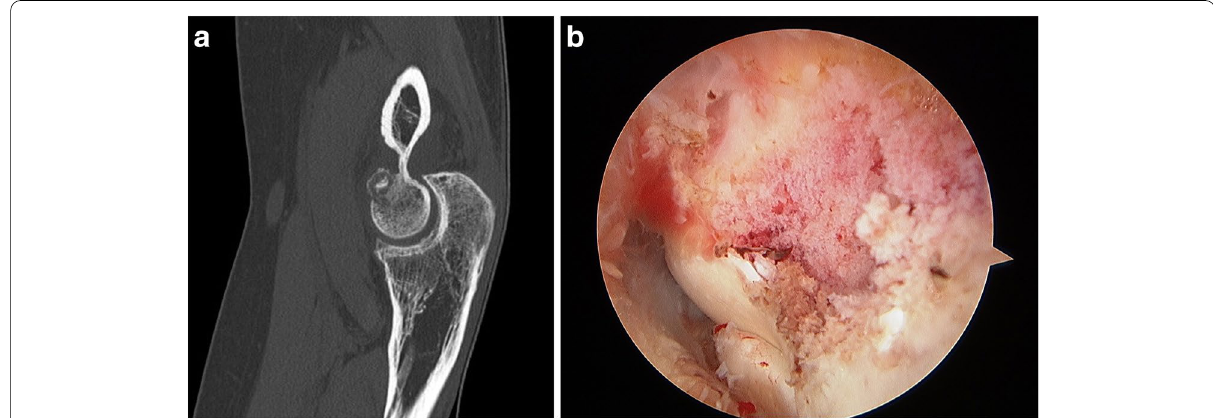
Fig. 6 Arthroscopic removal of an osteoid osteoma. A Preoperative CT scan, B Arthroscopic view of the nidus prior to